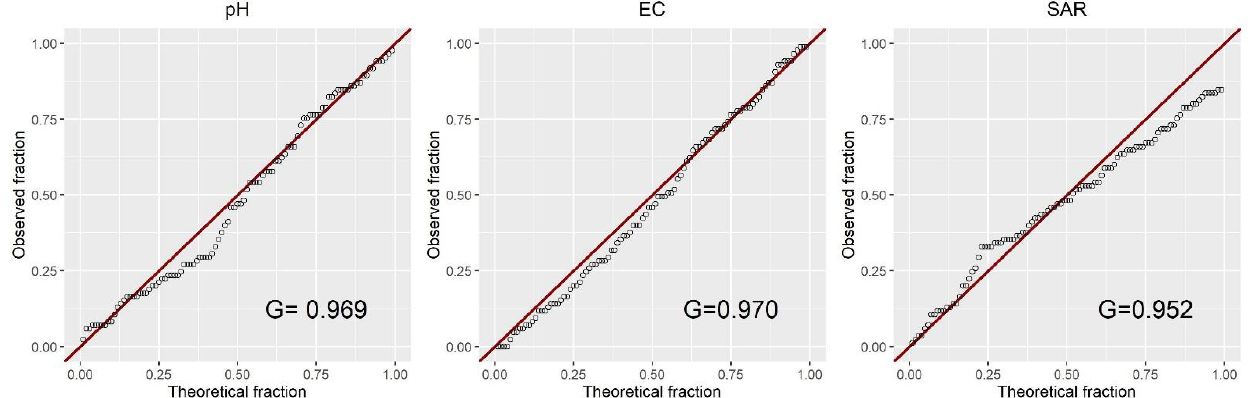
Figure 6. Accuracy plots with the computed G statistics. Legend: Abbreviations: EC: electrical con- ductivity, and SAR: sodium adsorption ratio. conductivity, and SAR: sodium adsorption